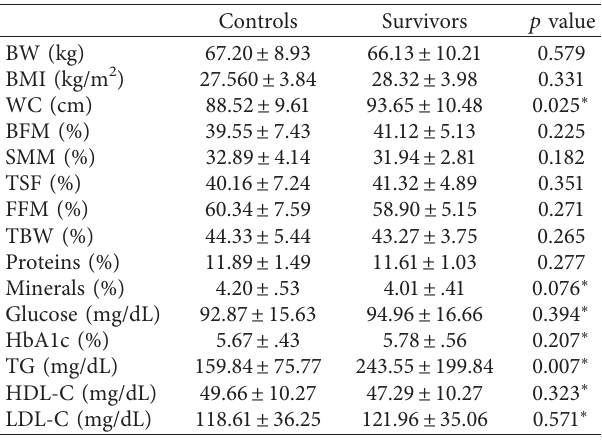
Table 3: Anthropometric characteristics, body composition, and biochemical markers in controls and BC survivors.